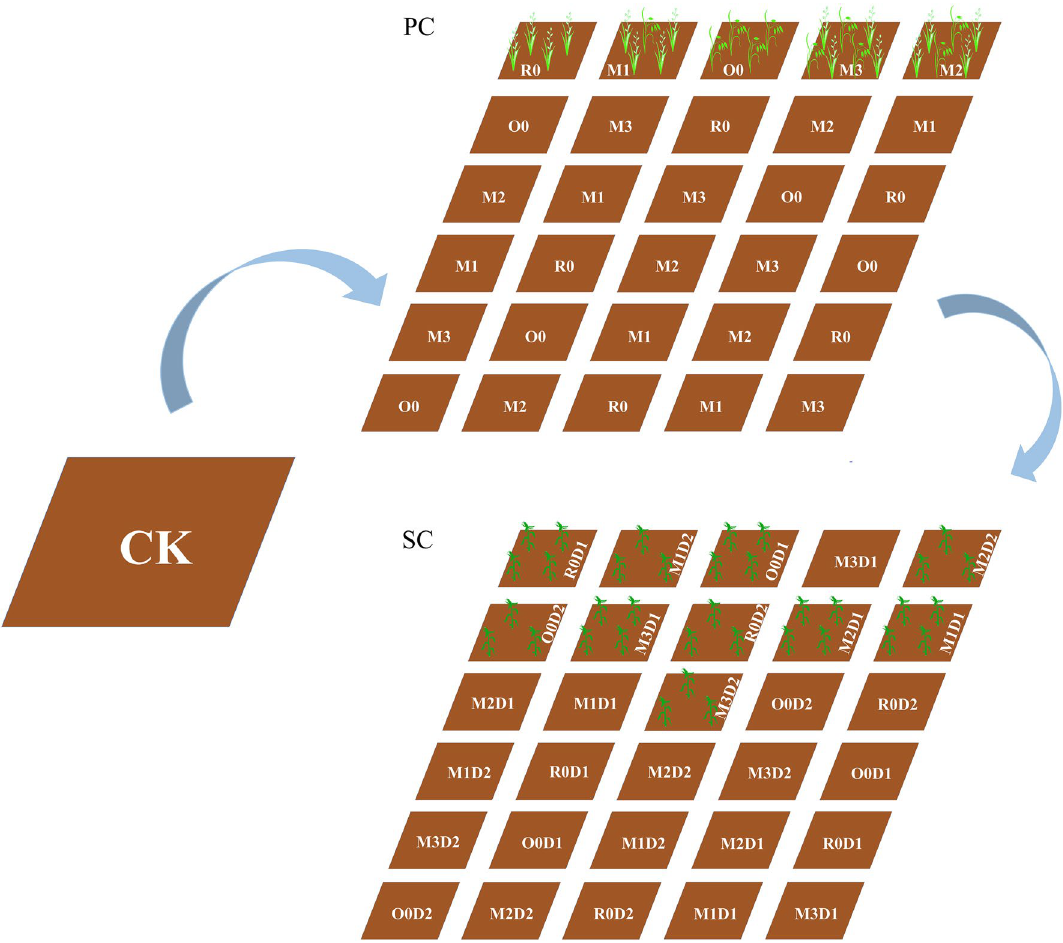
Figure 8. Diagram of experimental design of the ARMR system. CK, farmland fallowed for two years; PC, preceding crop, including O0 (22.5 kg·hm −2 ryegrass), R0 (150 kg·hm −2 oat), M1 (22.5 kg·hm −2 ryegrass mixed sowing with oat of 37.5 kg·hm −2 ), M2 (22.5 kg·hm −2 ryegrass mixed sowing with oat of 75 kg·hm −2 ) and